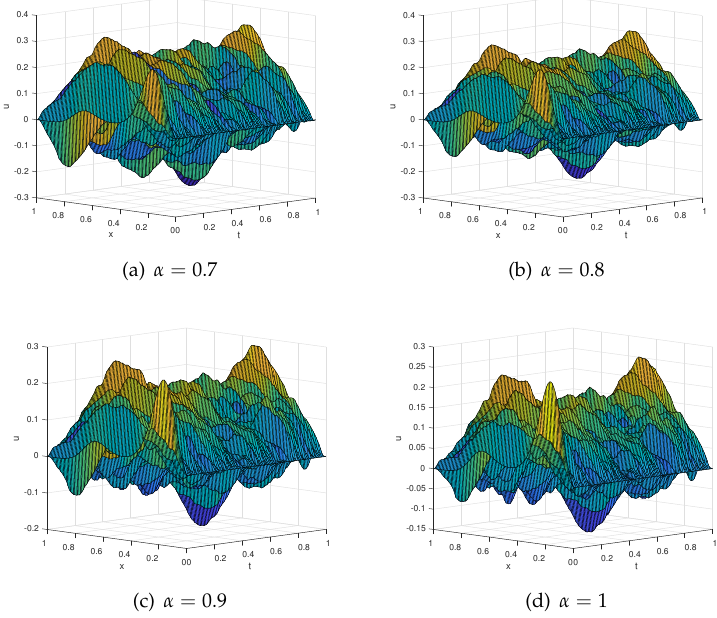
Figure 9. The approximation solutions of Example 2 (case (3)) with σ =